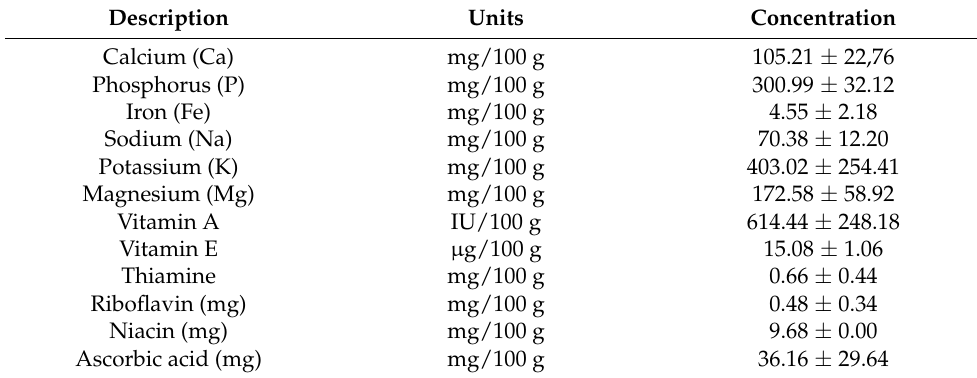
Table 1. Vitamin and mineral content of tomato [5].